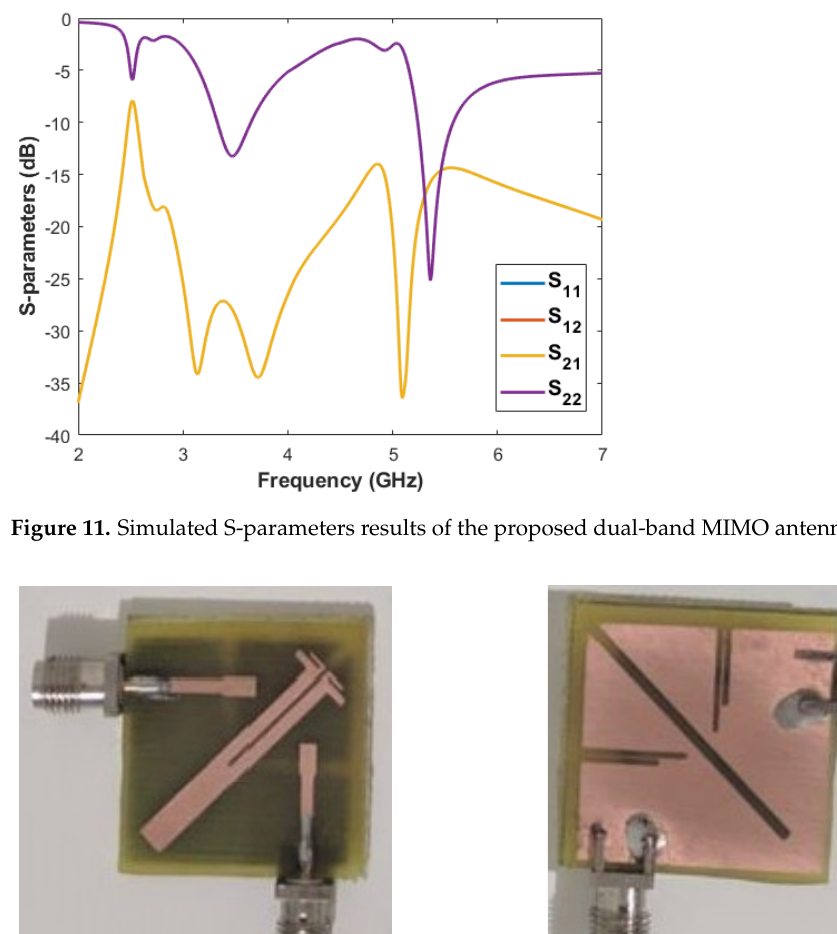
Figure 12. Dual-band MIMO antenna prototype: ( a ) top view and ( b ) bottom view.